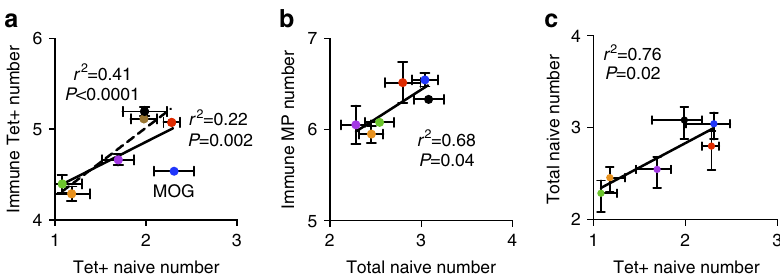
Figure 4 | Total precursor numbers predict expansion of CD4 þ T cells. Each point is a unique antigen-specific population: MOG 38–49 (blue), GP 66–77 (red), Aasf 24–32 (purple), FliC 427–442 (green), NP 311–325 (orange), 85b 280–294 (black), MOG 38–49 from MOG KO (brown). ( a ) Number of naive Tet þ CD4 þ Tcells (log transformed) compared with Tet þ CD4 þ Tcells 14 days after immunization (log transformed; n ¼ 5–6 mice per group, data represented as mean ± s.e.m.). ( b ) Number of antigen-specific CD4 þ Tcells (log transformed) identified by MP after immunization correlated with previously calculated precursor numbers (log transformed; expanded data: 12 experiments, two to three mice per point, data represented as mean ± s.e.m.). ( c ) Correlation of the number of naive T cells (both log transformed) as identified by tetramer and LDA (data represented as mean ± s.e.m.).